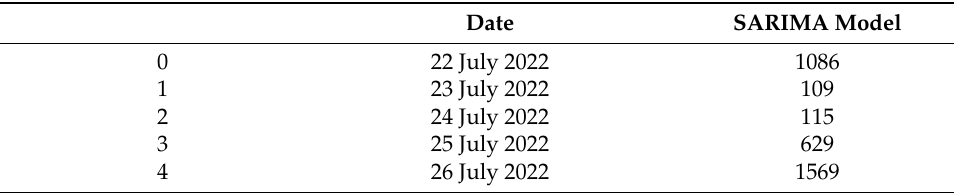
Table 8. SARIMA model confirmed case prediction over five days.